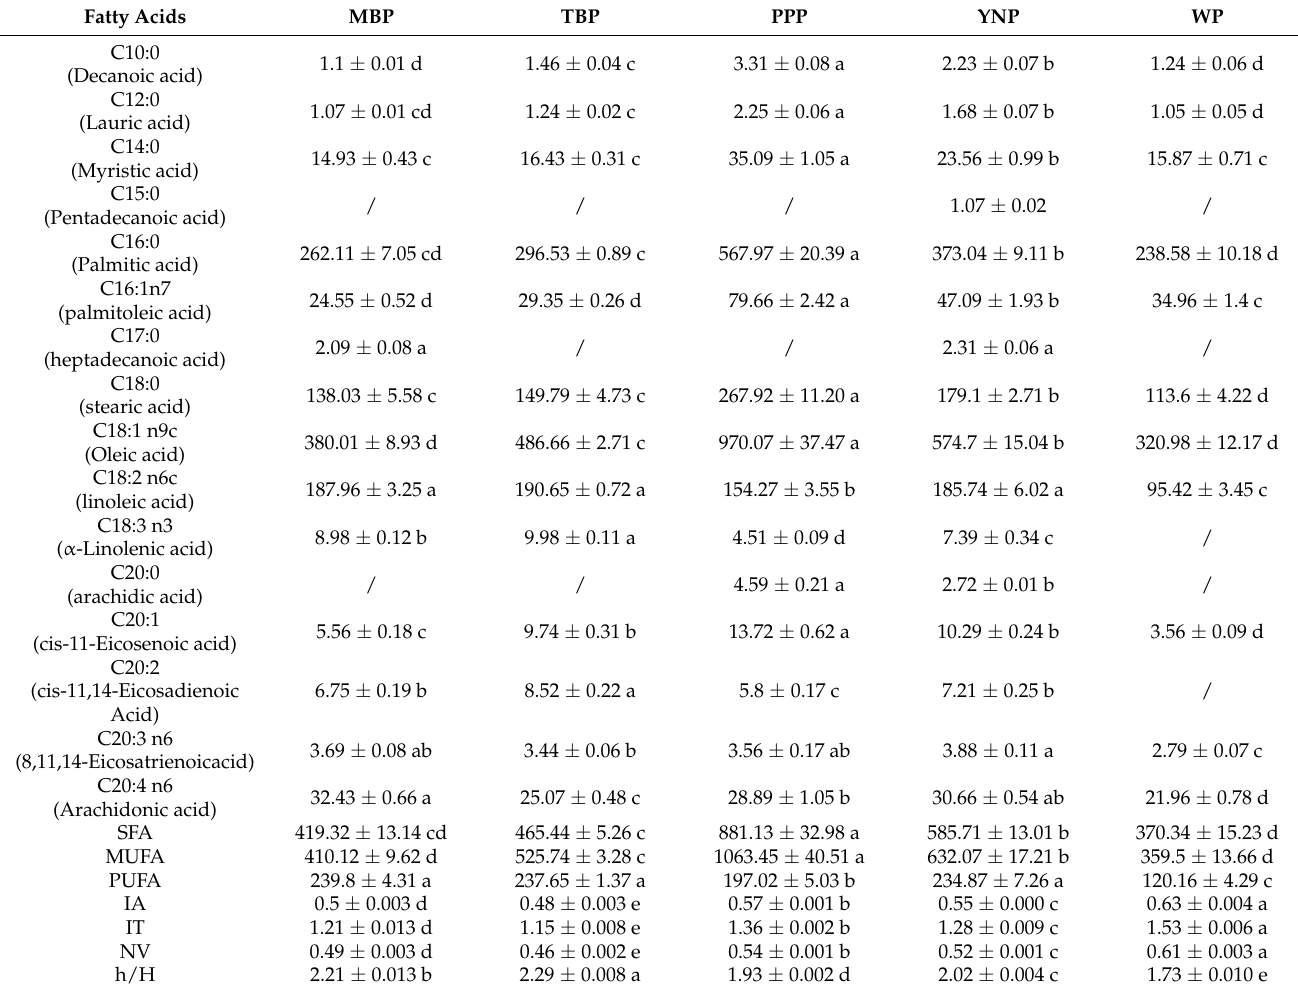
Table 3. Fatty acid profiles of the five types of pork (mg/100